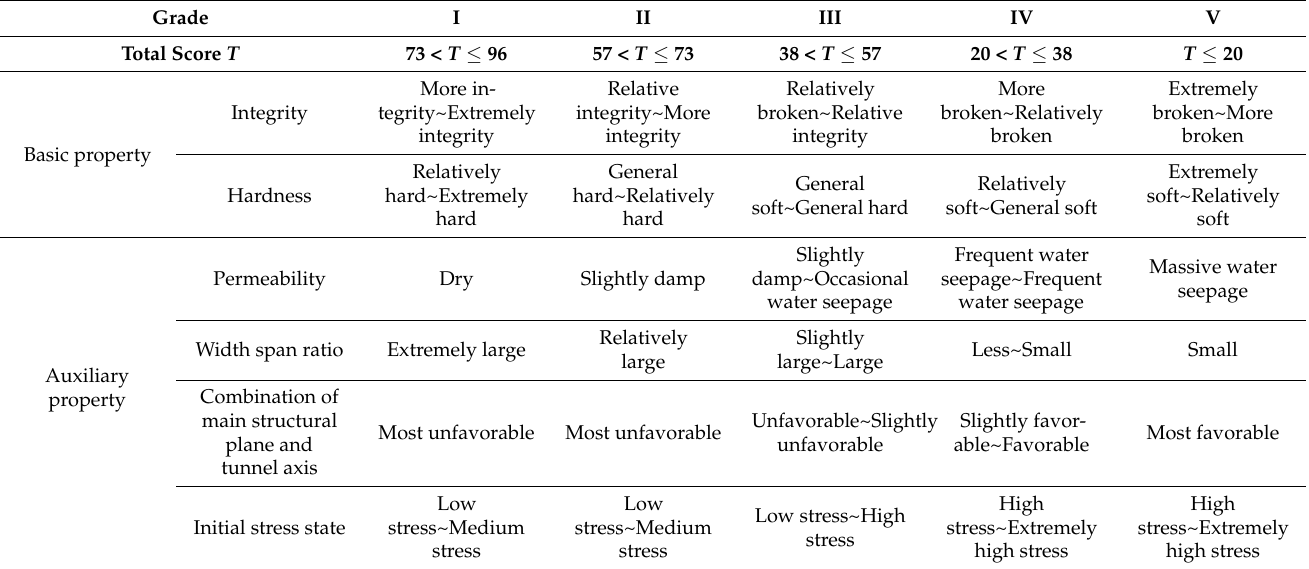
Table 13. Grade and score range of middle rock pillar.